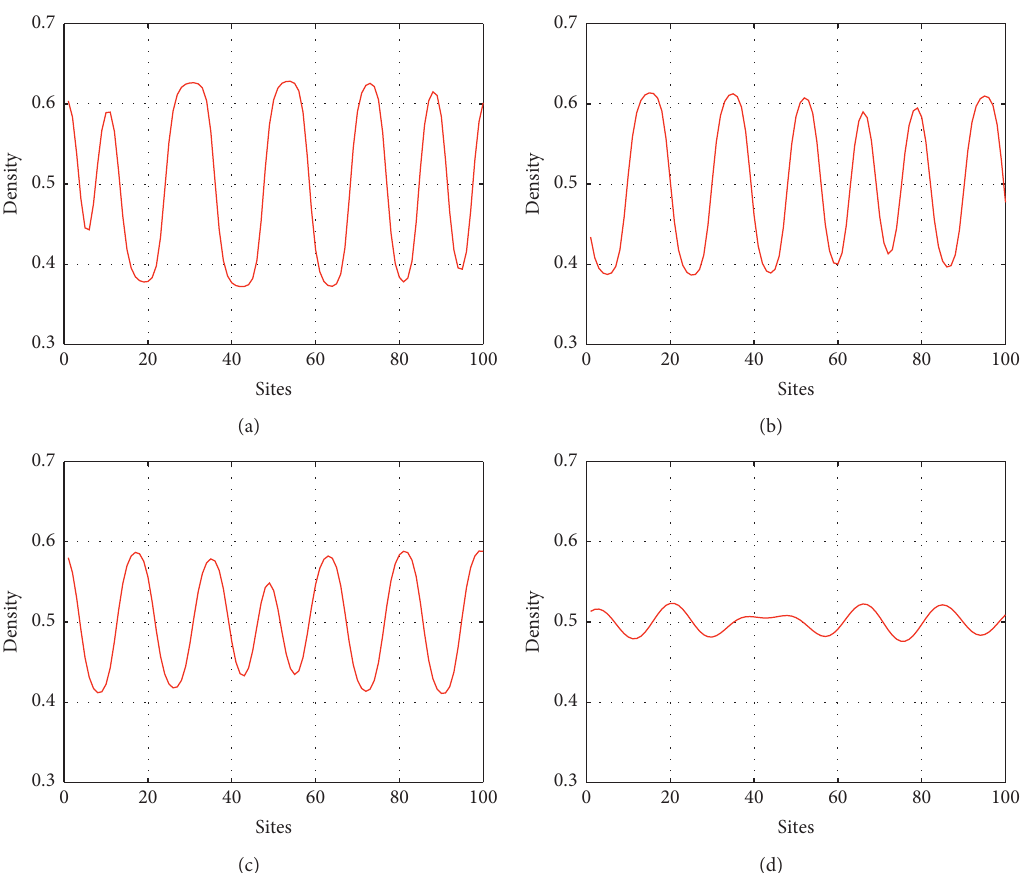
Figure 8: Density profile of the density wave at t � 10300 s corresponds to Figure 7. (a) c � 0, (b) c � 0.1, (c) c � 0.2, (d) c �